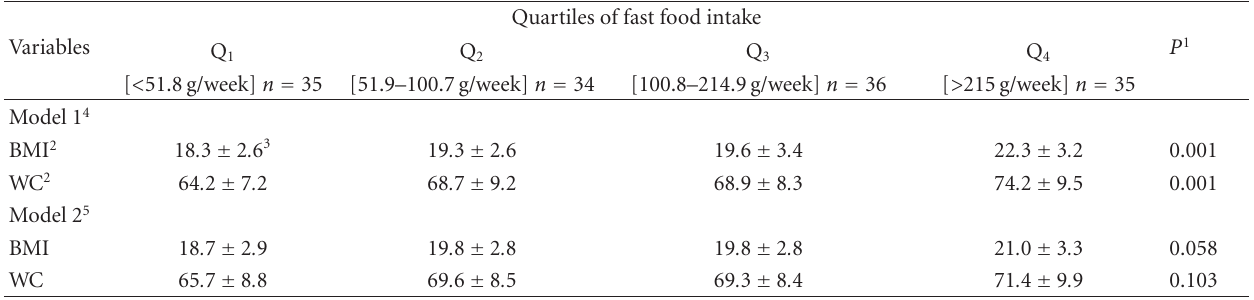
Table 4: Body mass index and waist circumference trend across fast food quartiles.